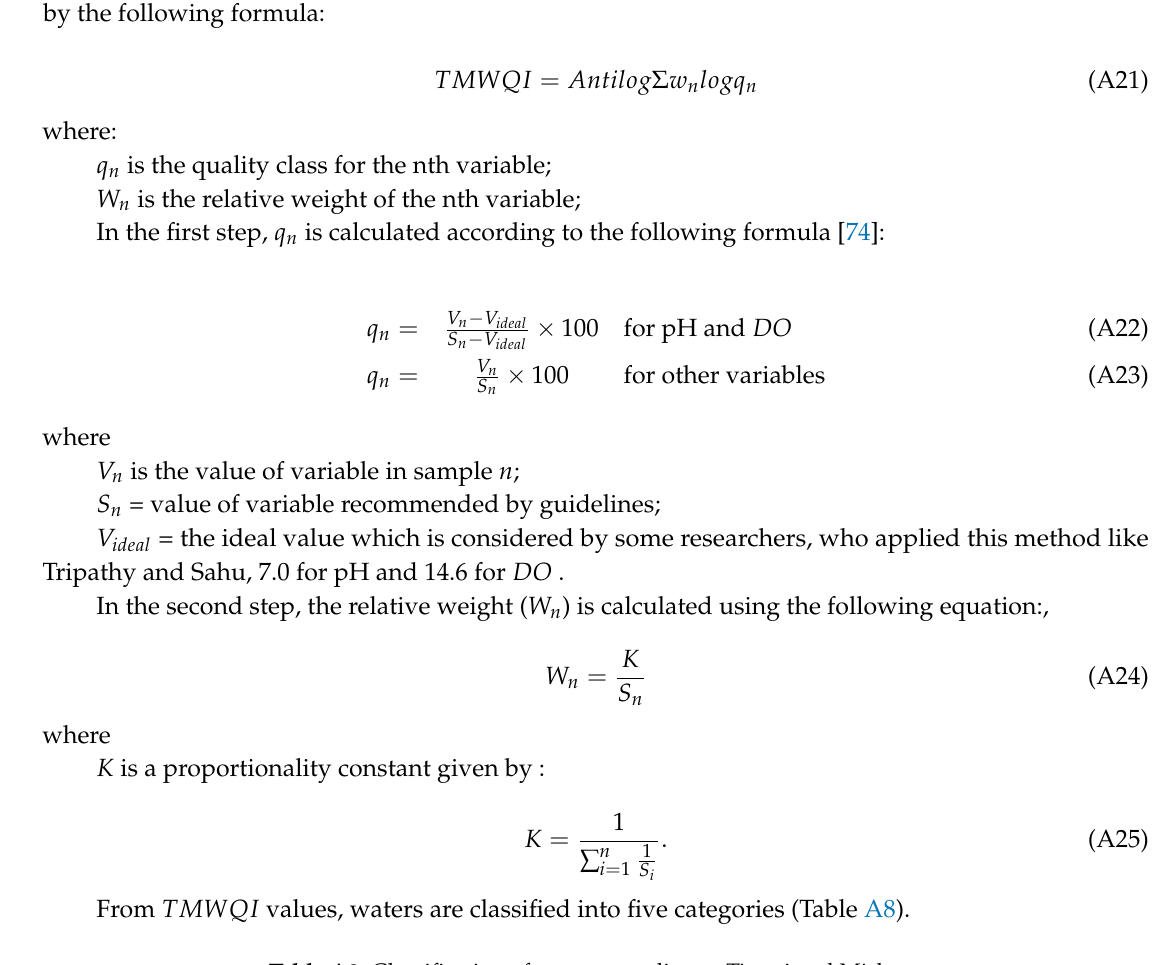
Table A8. Classification of water according to Tiwari and